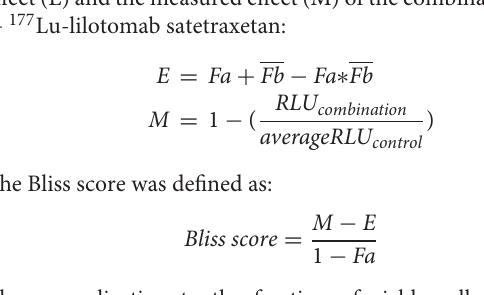
FIGURE 7 | showing percentage of cells positive for cleaved PARP ( n = 4; error bars represent standard error of mean ( n = 4). (A,B) Statistical significance in differences between treatment groups were tested by One Way ANOVA: * p < 0.05, ** p < 0.01, *** p < 0.001. (C) Model: treatment with 177 Lu-lilotomab satetraxetan leads to DNA-damage induced G 2 arrest and apoptotic cell death. Cells resistant to treatment adapt and recover from the arrest. Inhibition of CDK1 and AURKA/B interferes with bipolar- and mid-spindle assembly, causing chromosome congression and cytokinesis defects. Combined treatment with JNJ-7706621 and 177 Lu-lilotomab satetraxetan reverses resistance likely by potentiating the effect of persistent radiation due to extended residence time in and failure of mitosis, the cell cycle phase in which repair capacity is